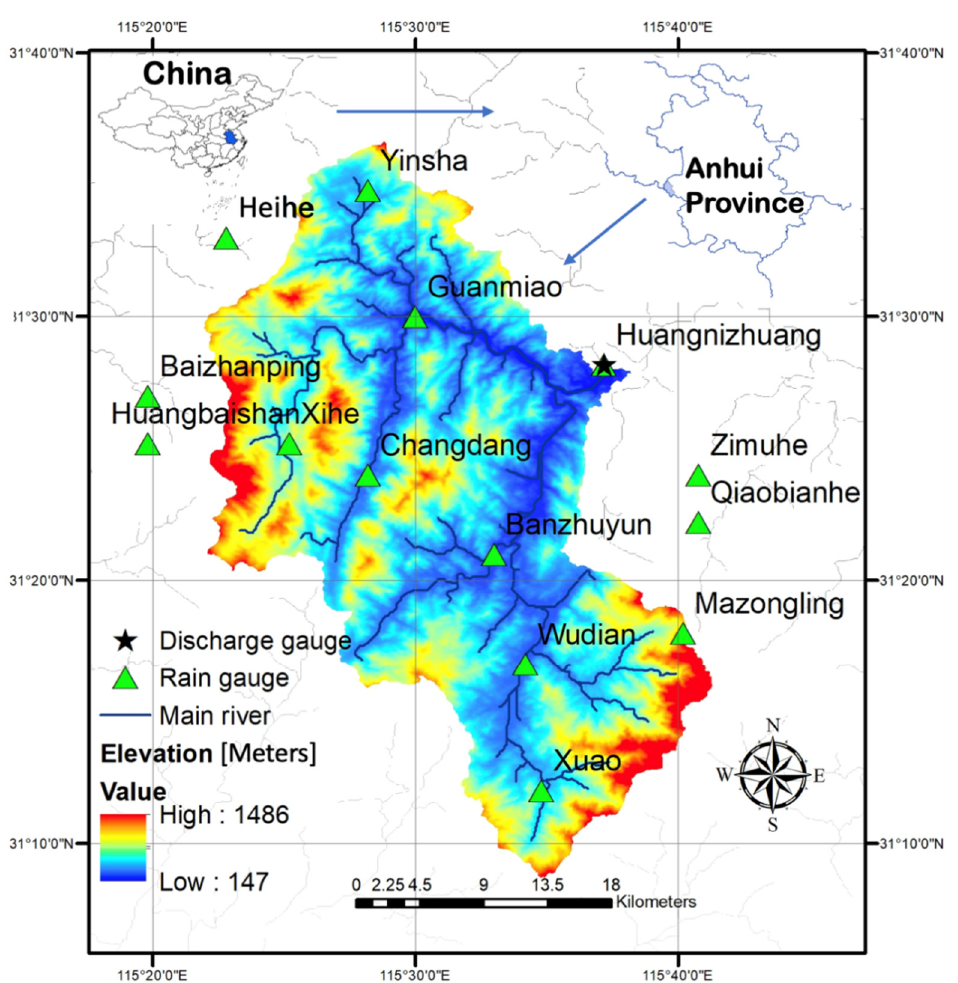
Figure 1. Morphology of the upstream Shiguan River with the location of the hydrometeorological monitoring network.